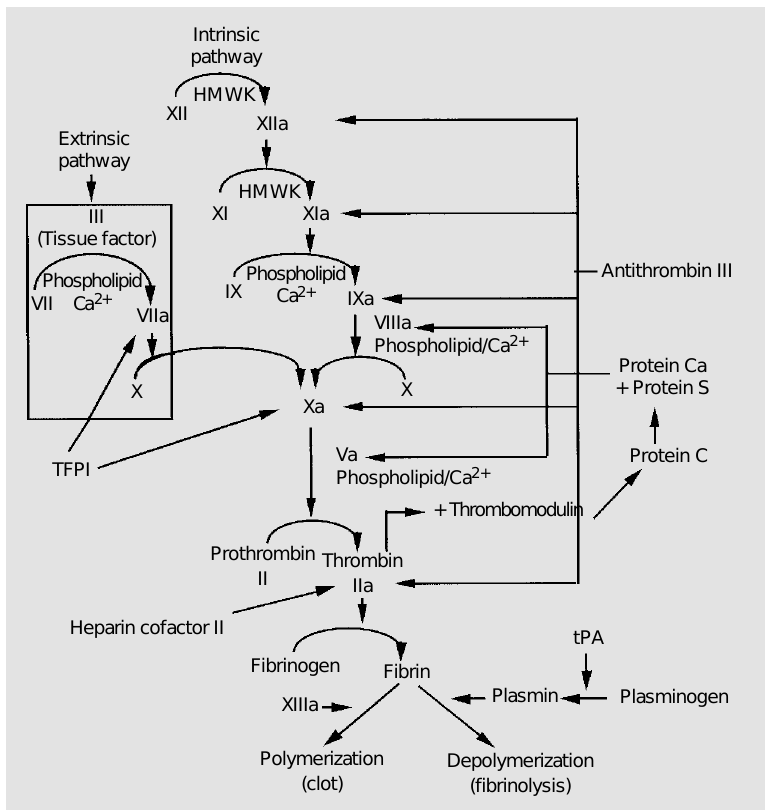
Figure 2. Coagulation cascade. HMWK, high molecular weight kininogen; TFPI, tissue factor pathway inhibitor; tPA, tissue